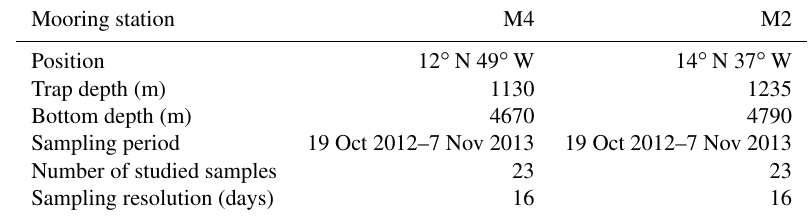
Table 1. Background information regarding the DUSTTRAFFIC sediment trap moorings (M4 and M2) used in this study. Mooring